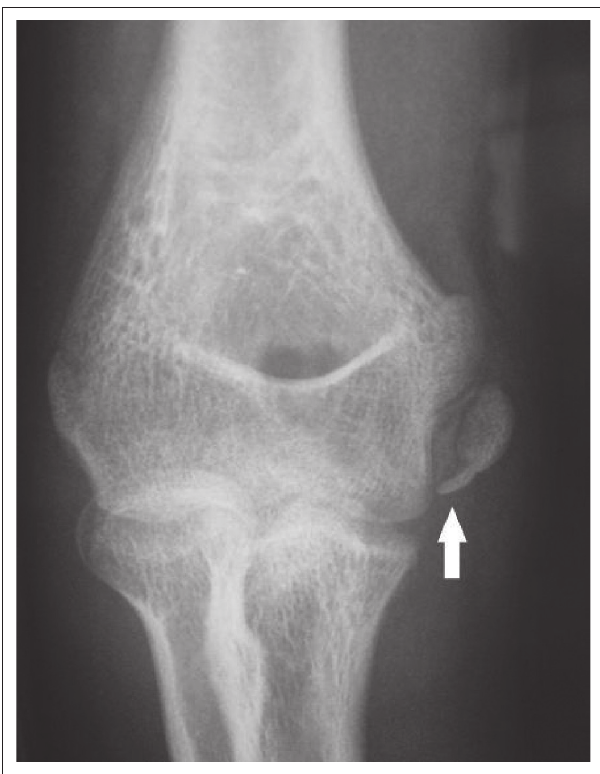
FIGURE 13: A 12-year-old with direct blow to elbow. Note the lateral soft tissue swelling and linear fracture through the lateral epicondyle